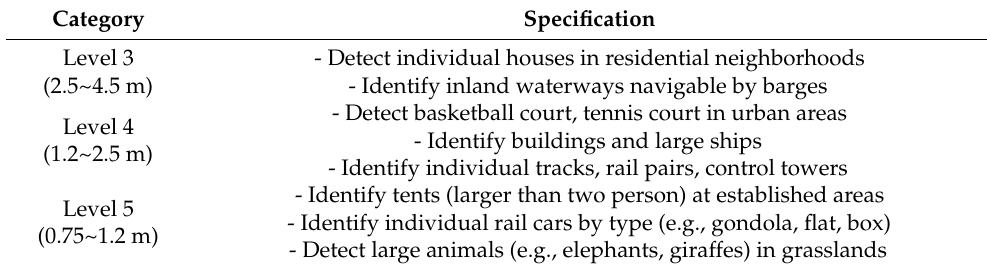
Table 1. Civil National Image Interpretability Rating Scale category of radar images